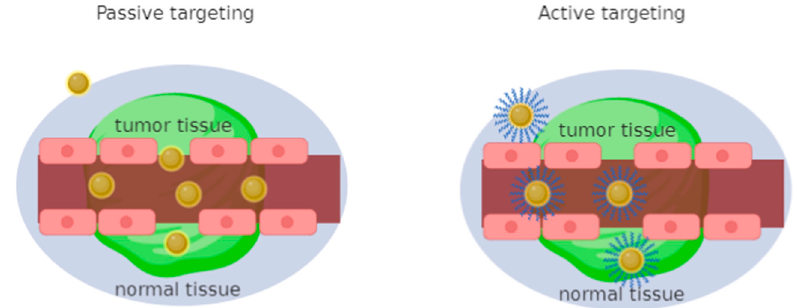
Figure 1. Schematic illustration of targeted strategies for cancer therapy by functional Gold Nanoparticles (Au-NPs, NPs = NanoParticles). Malignant tissue is distributed unevenly concerning healthy cells, hence the gold nanoparticles that cross the empty spaces due to the increase in permeability and the retention effect of passive drug release. This figure also illustrates active targeting with direct binding of gold nanoparticles to receptors with specific ligands.